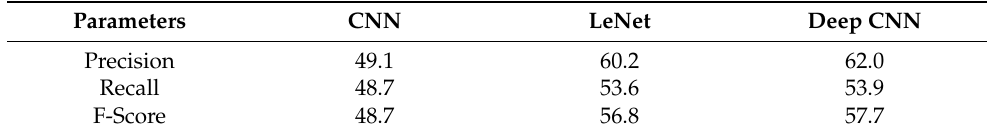
Table 7. Precision, Recall, and F 1 -Score Comparison of CNN, LeNet, and Deep CNN Models on the Combined Pashto Digit and Character Dataset.